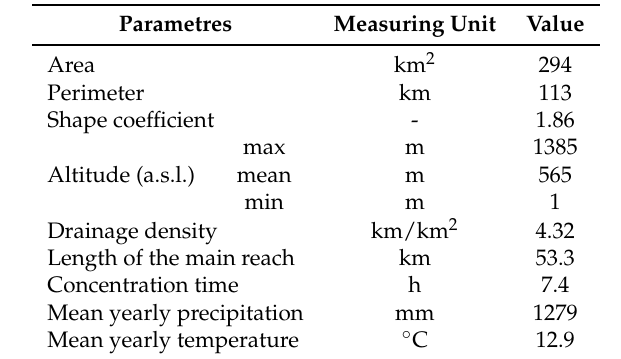
Figure 4. Location, drainage area and hydrographic network of Corace watershed (Calabria, Southern Italy). Table 1. Main morphometric parameters of Corace watershed (extracted from the